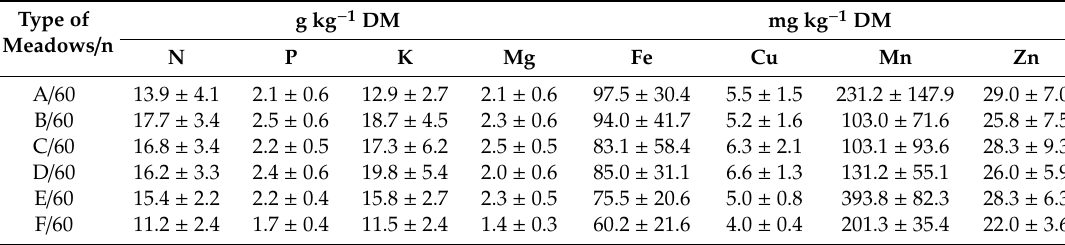
Table 1. Macro- and micro mineral concentrations dry mass (DM) in the sward (mean ± SD). A—optimally moist habitat, poor soils, fresh meadows; B—optimally moist habitat, fertile